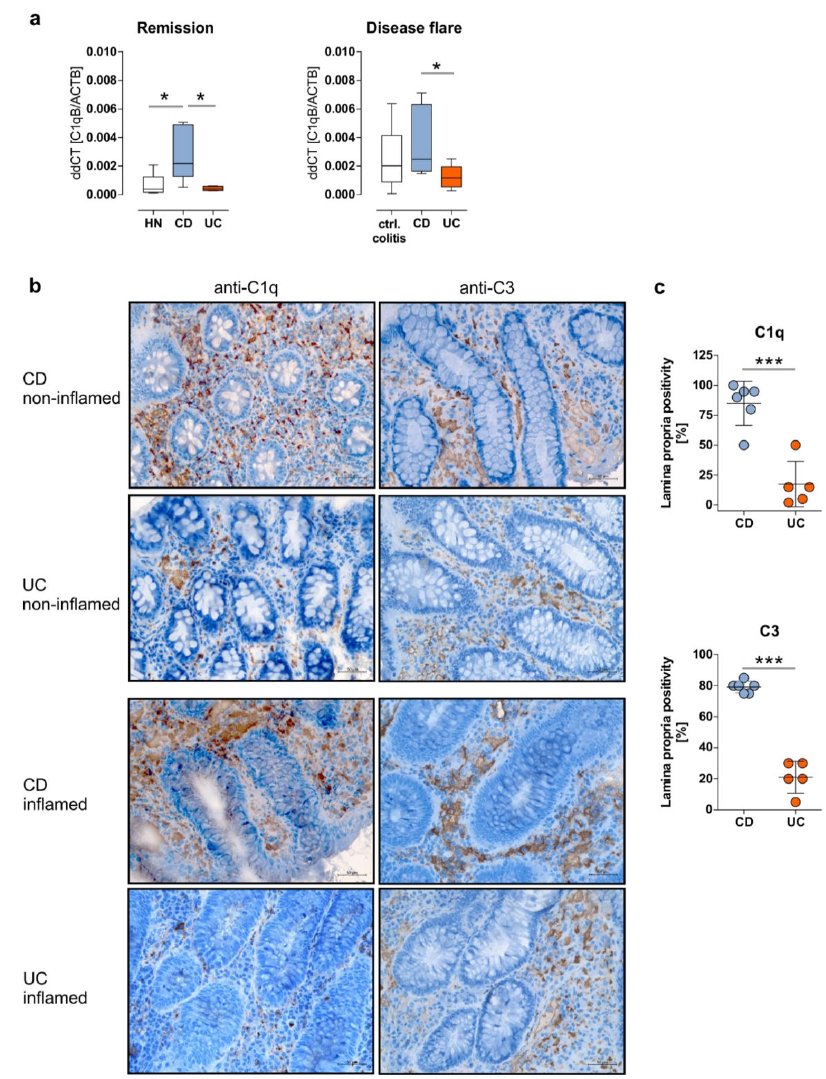
Figure 2. CD patients in remission display an over-representation of mucosal C1q and C3 expression. ( a ) The mRNA expression of C1QB in non-inflamed (ni) sigmoidal biopsy samples from IBD patients in remission or HNs, as well as from inflamed sigmoidal biopsy samples from IBD patient with active disease or control colitis patients was analyzed by qPCR using C1QB specific oligonucleotides. ddCt values are depicted. * p ≤ 0.05. ( b ) Representative pictures of C1q (left panels) or C3 staining (right panels) in colonic tissues from CD or UC patients (non-inflamed or inflamed) (original magnification: 20 × ). ( c ) Percentages of C1q or C3 positivity of the lamina propria were determined in analyzed CD (n = 6) or UC (n = 5) tissue samples, irrespectively of the inflammatory status. *** p ≤